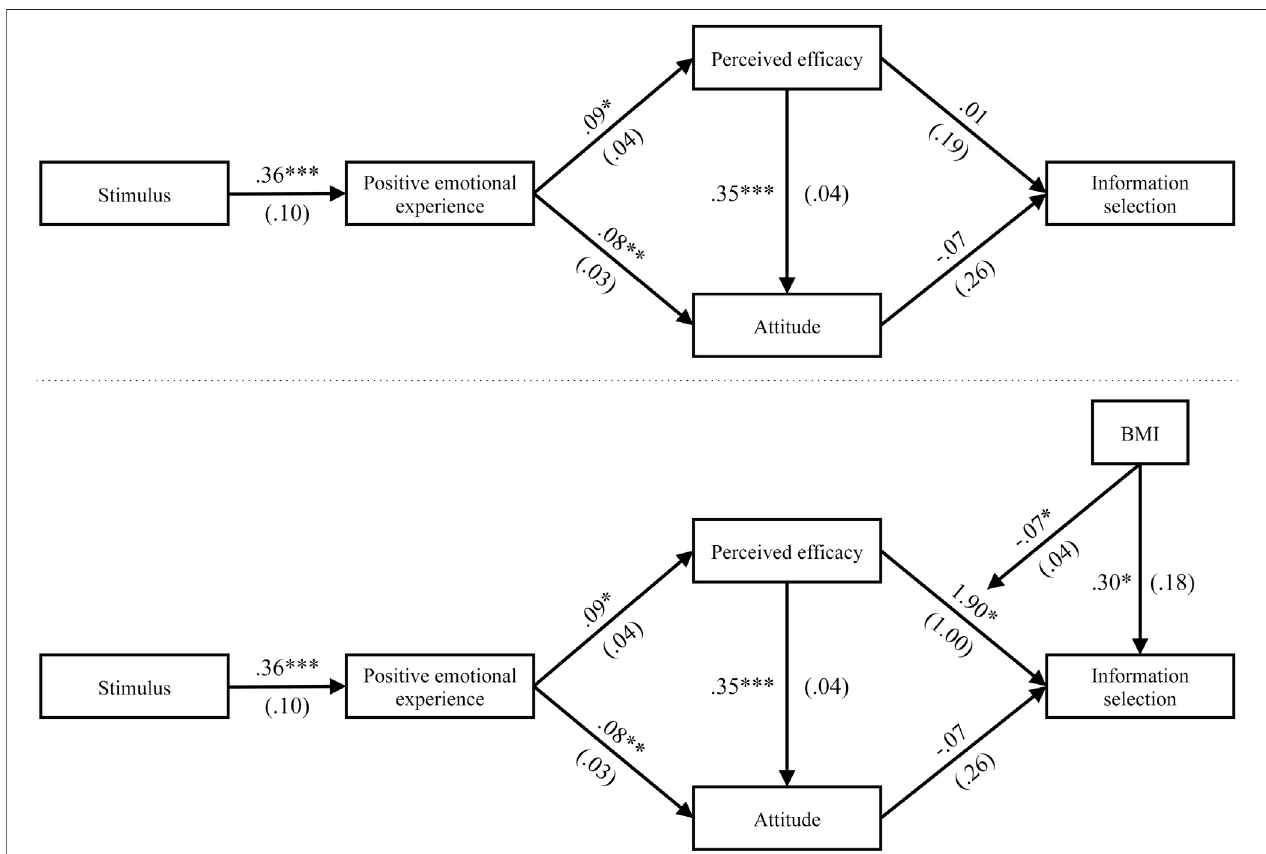
FIGURE3| ResultsStudy2:Effectofthestimulusonactualinformationseeking (top) andonactualinformationseekingwithBMIasmoderator (bottom) mediated by positive emotional experience and perceived ef fi cacy. Stimulus was dummy coded (negative (cid:1) 0, positive (cid:1) 1); positive emotional experience and perceived ef fi cacy (1 (cid:1) don ’ t agree at all, 5 (cid:1) totally agree); attitude toward healthy nutrition and exercise behavior (1 (cid:1) unfavorable attitude, 5 (cid:1) favorable attitude); information selection was dummy coded (selection of topic unrelated article (cid:1) 0; selection of topic-related article (cid:1) 1). All regression coef fi cients are unstandardized; standard error in parentheses. * p < 0.05, ** p < 0.01, *** p <